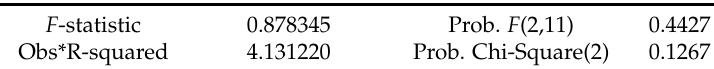
Table 6. Breusch-Godfrey Serial Correlation LM Test.